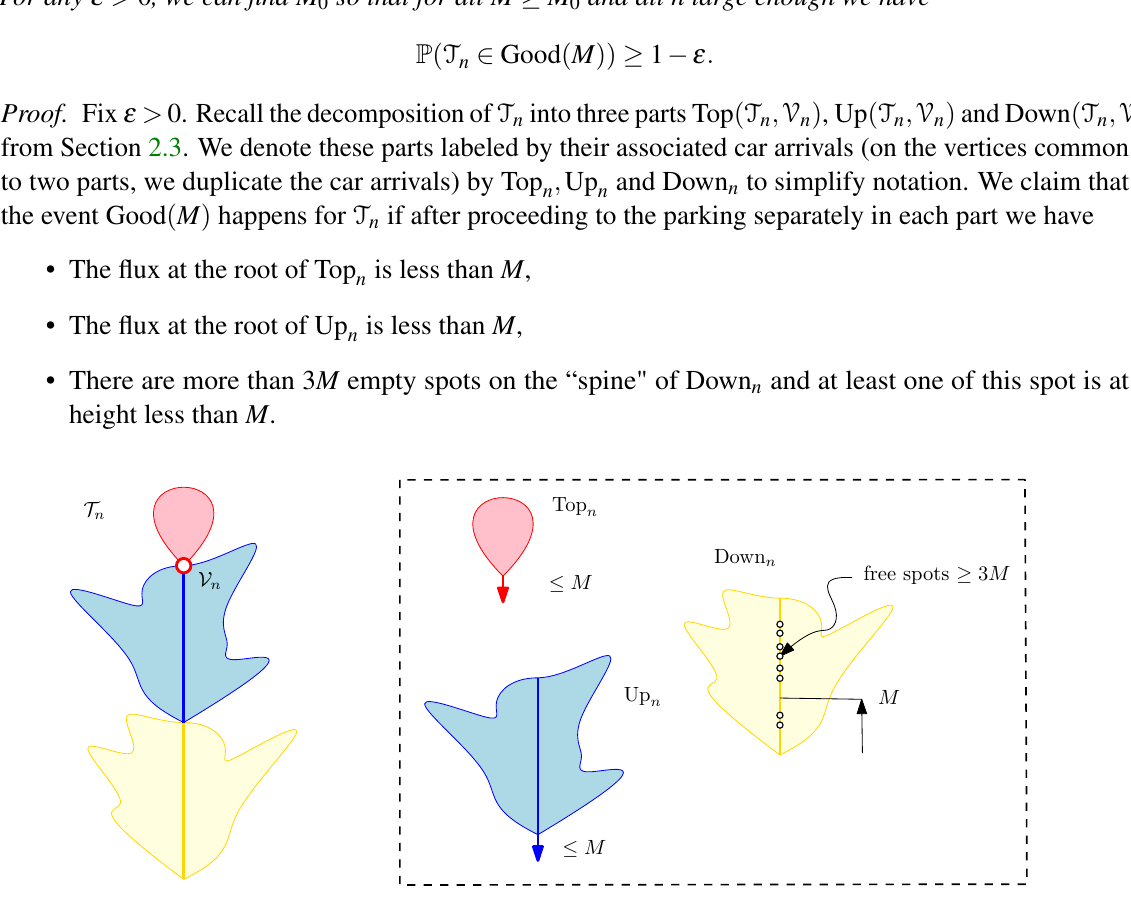
Figure 5: On the right, the three events ensuring Good ( M ) happens are realized for each of the three parts Top , Up and Down n . After gluing back the pieces together and parking, the flux coming down from n n Top and Up will be absorbed by the empty spots on the spine of Down n , and an empty spot will remain n n on the spine of Down n at height less than M